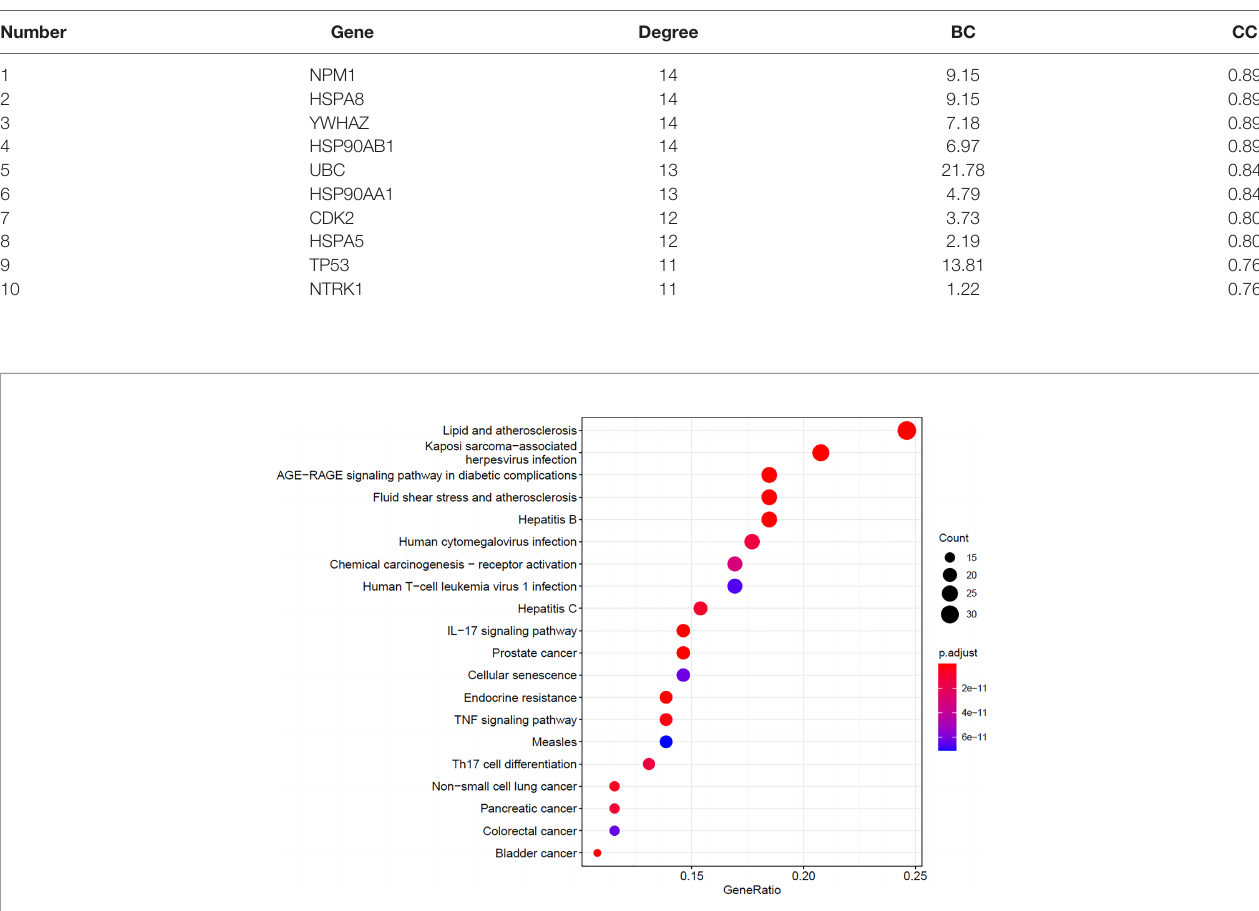
TABLE 3 | Analysis of topology parameters.